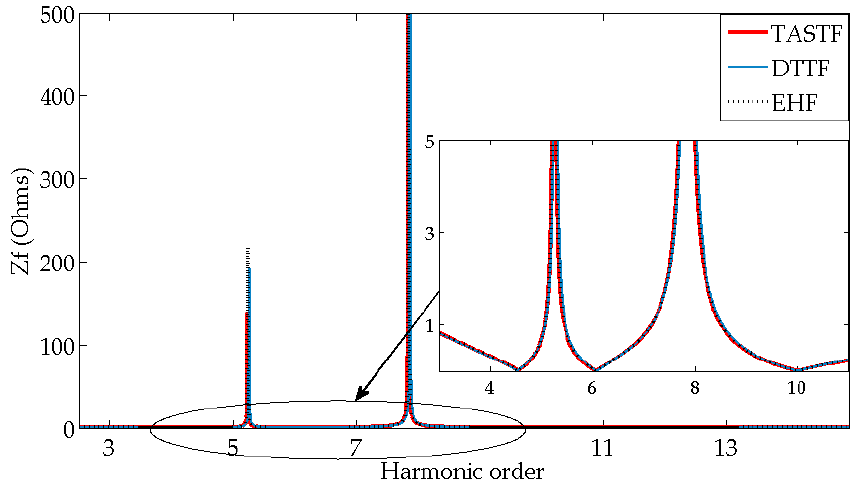
Figure 13. The filter impedance of TASTF, DTTF, and